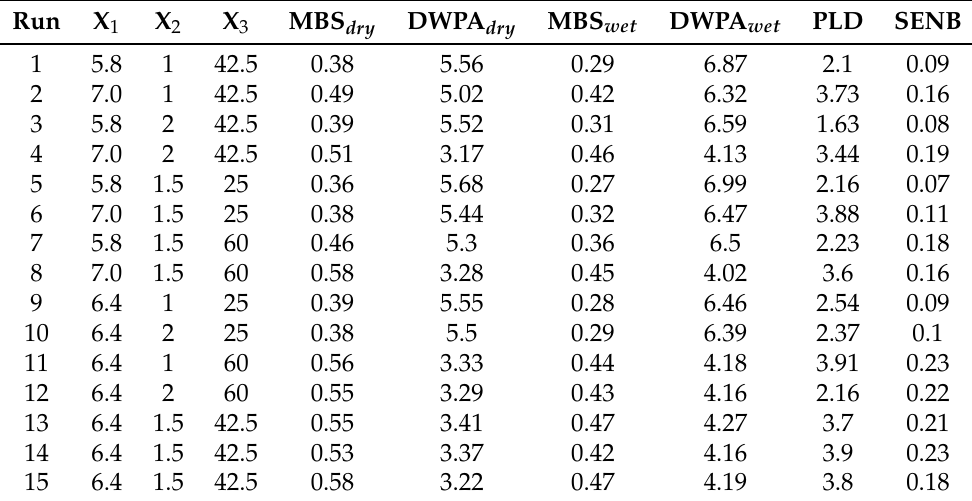
Table 3. Result of the experimental design by